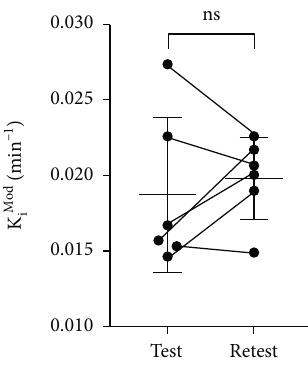
K i Mod outcome values. i Mod